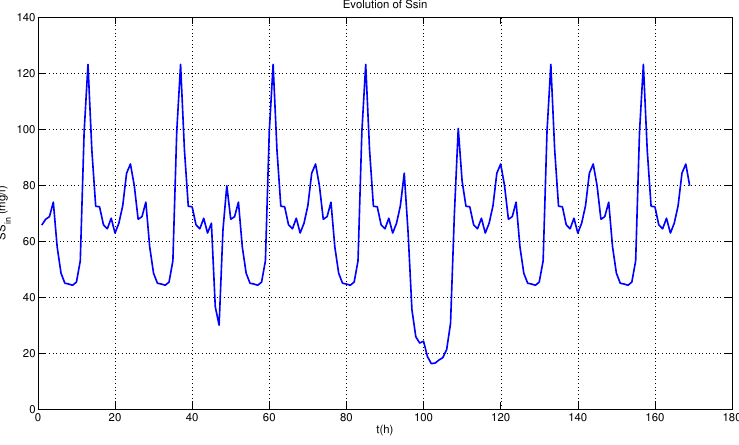
Figure 4. Concentration of organic matter in the influent S s